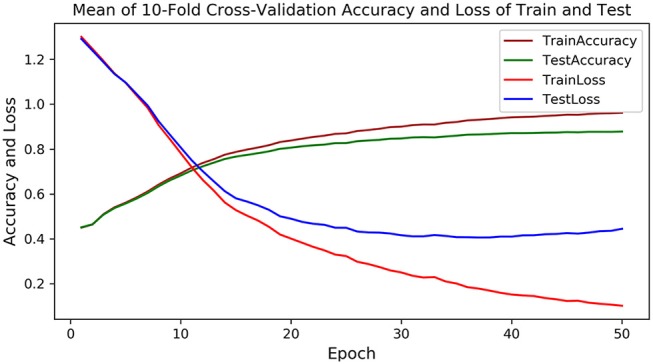
The mean accuracy and loss of training and testing in the 10-fold cross-validation experiments, in which the brown and green curve represents the accuracy of training and testing, and the red and blue curve represents the loss of training and testing.